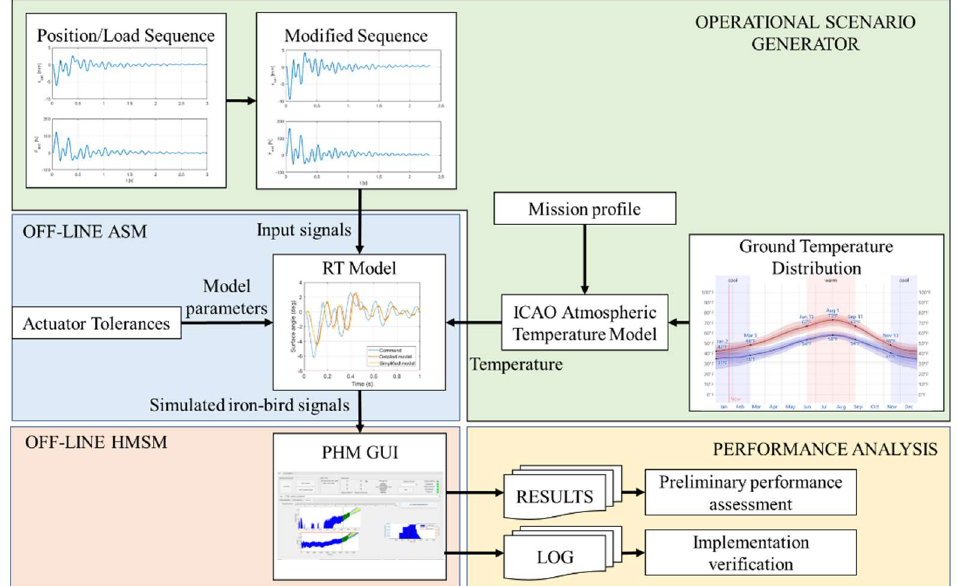
Figure 20. Procedure for the preliminary performance